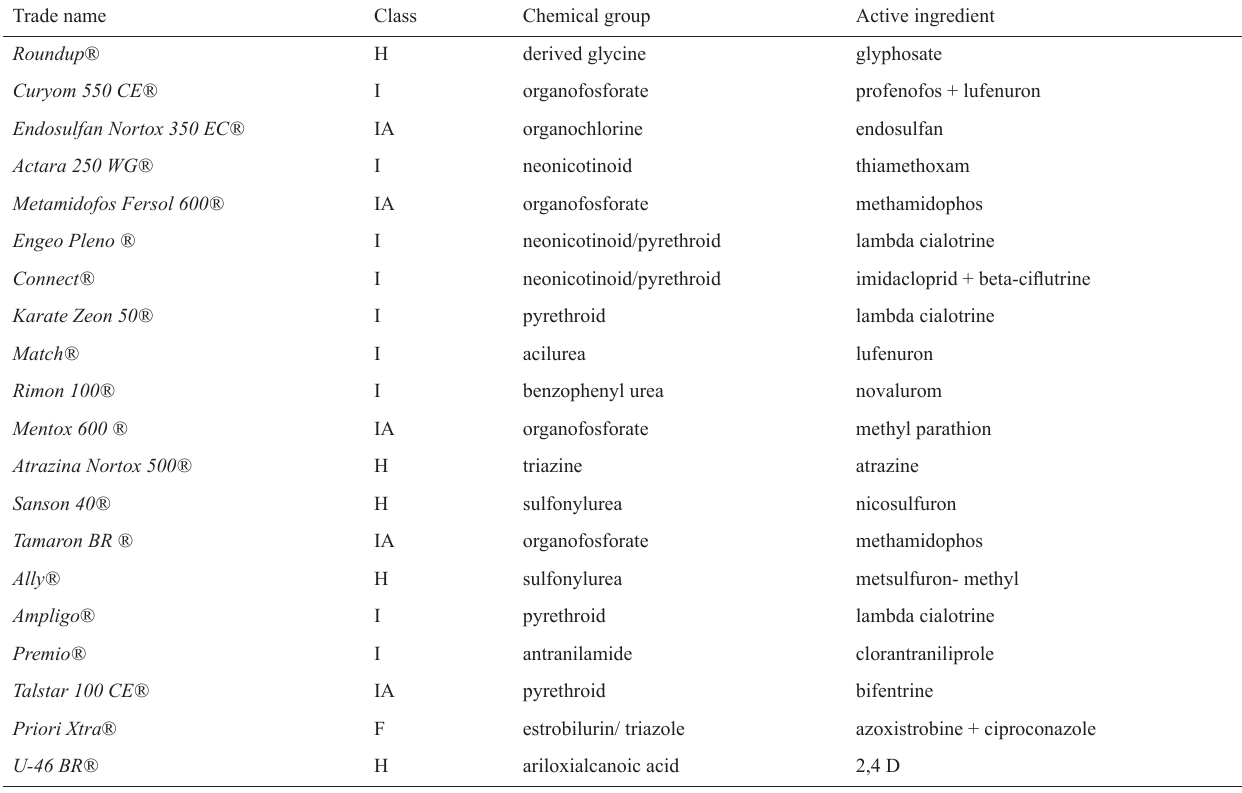
Table 2. Most used pesticides in the watershed area of the Água das Araras stream. Class: H = herbicide; I = inseticide; IA = inseticide/acaricide; F =